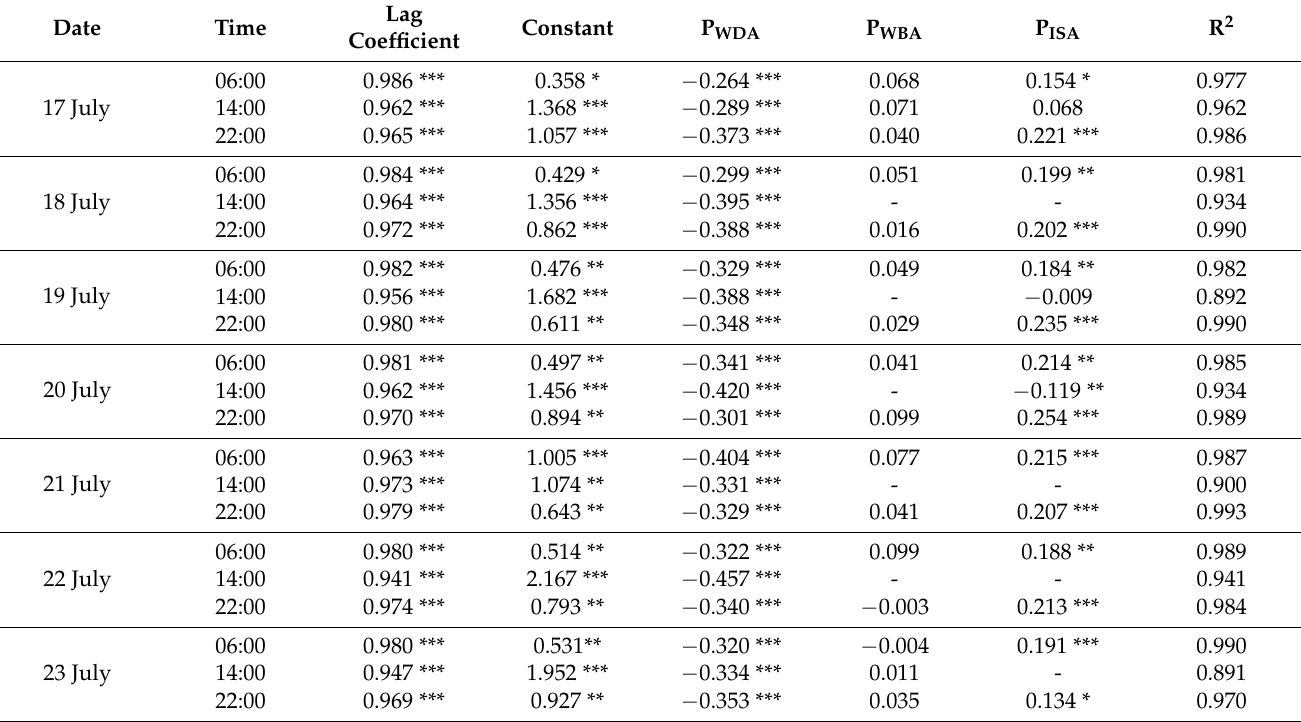
Table 3. Coefficients of the SLM regression with respect to the air